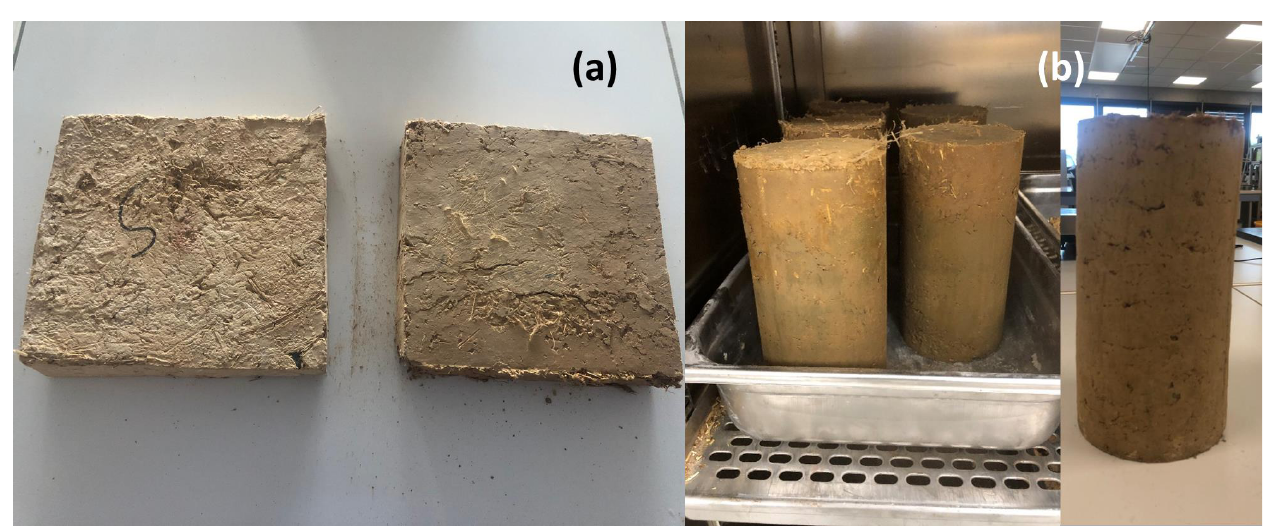
Figure 3. Structural cob samples used for ( a ) thermal tests and ( b ) mechanical tests.